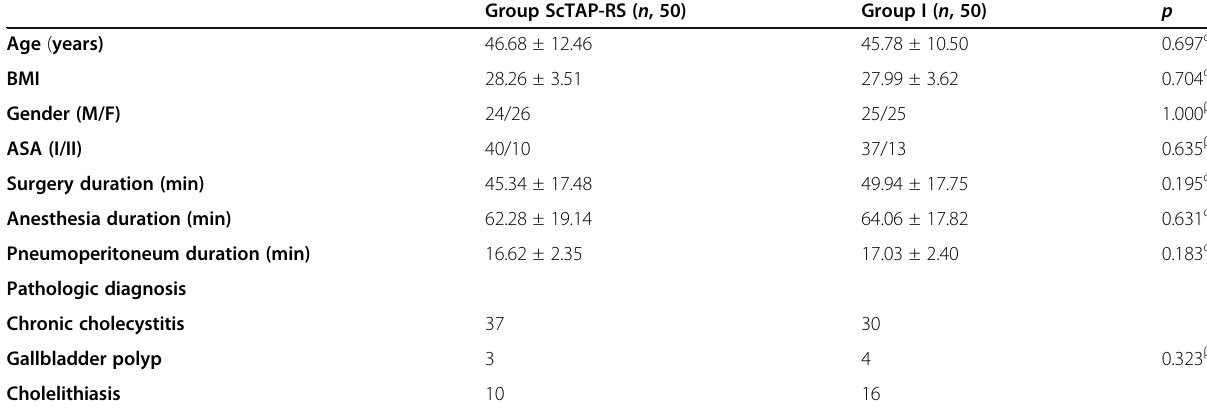
Table 1 Demographic datas and comparison of duration times between group ScTAP-RS and group I